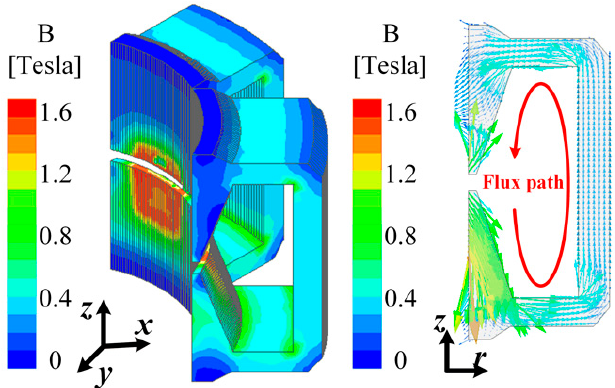
Figure 2. Magnetic flux density and flow of the LOM.